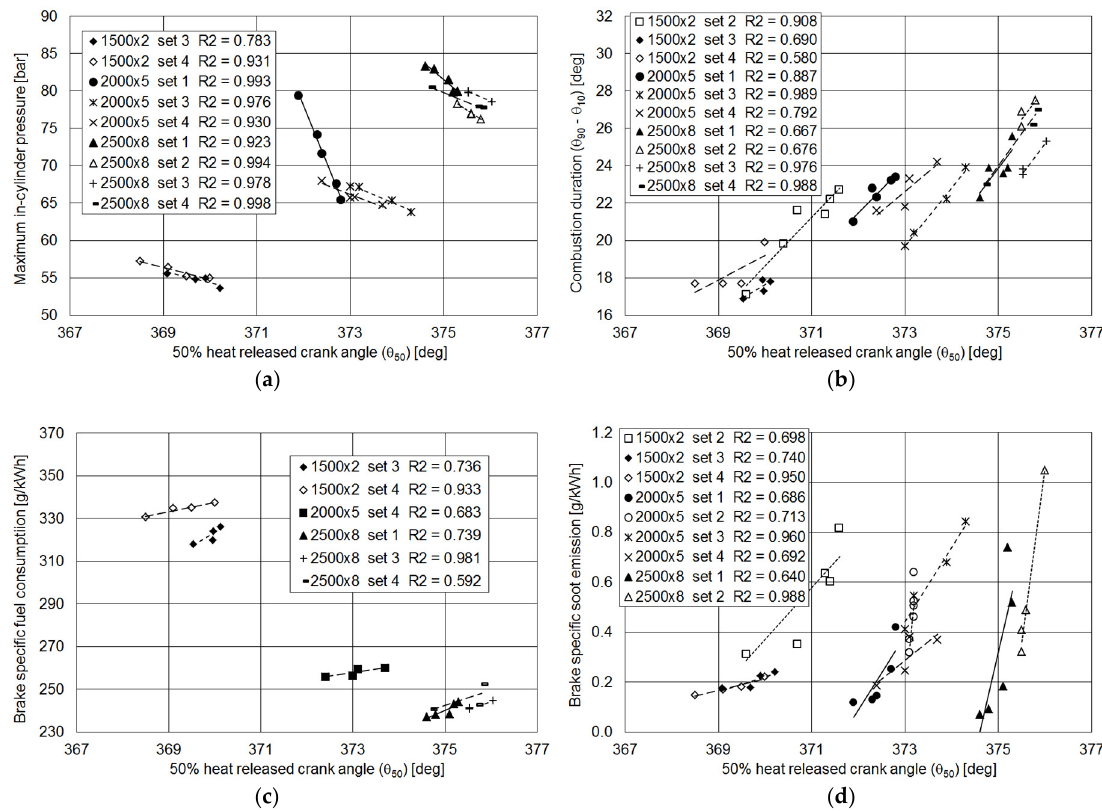
Figure 10. Relationship between θ 50 and p MAX ( a ), (θ 90 –θ 10 ) ( b ), bsfc ( c ), bsS ( d ) in different test sets.